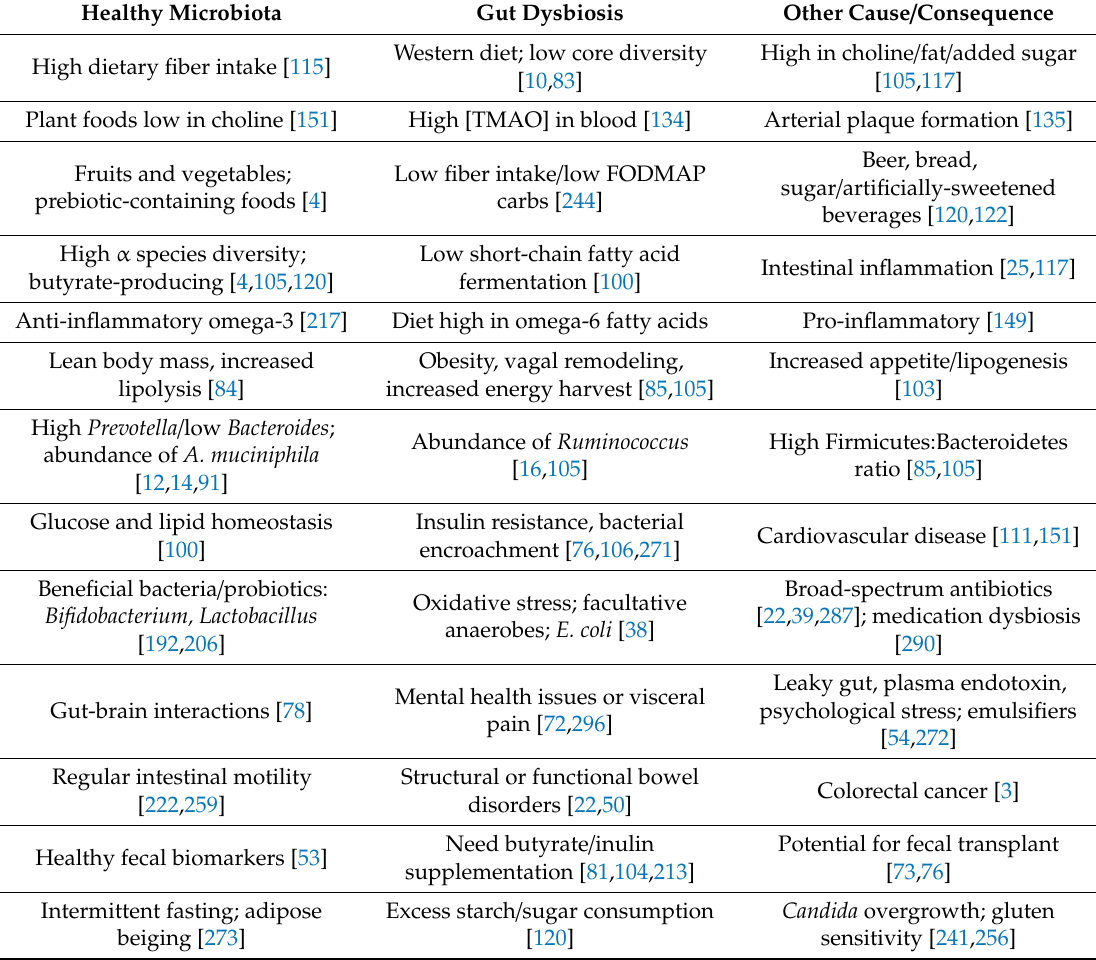
Table 1. Summary of diet-microbiota interactions in health and